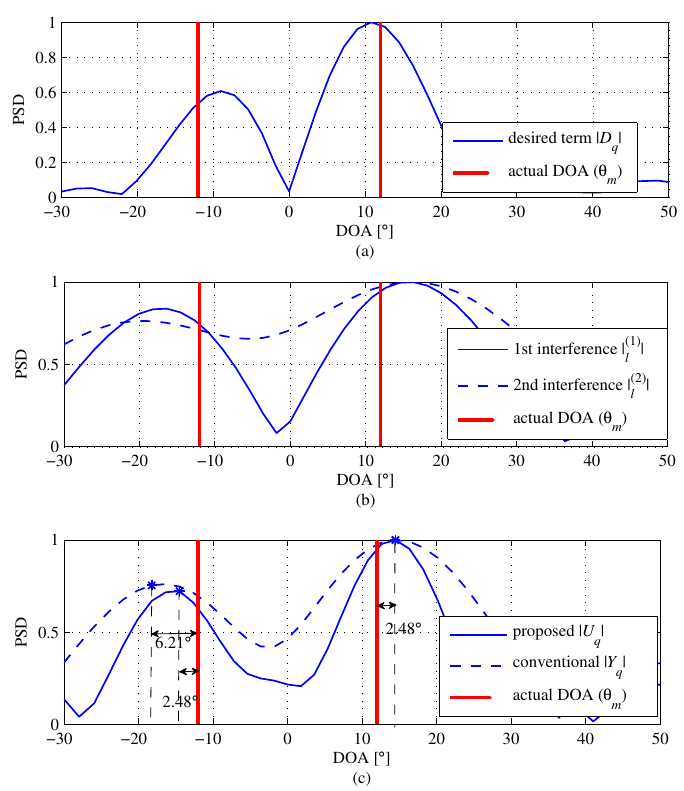
Figure 5. Snapshots of DFT outputs of the proposed algorithm with K = 5 ( K Ex = 9 ) , SNR = 10 dB and M = 2 to observe the e ff ect due to interference terms on the overall system performance ( a ) comparison between the desired term and actual DOA; ( b ) comparison between interference terms and actual DOA; ( c ) comparison between the proposed and the conventional